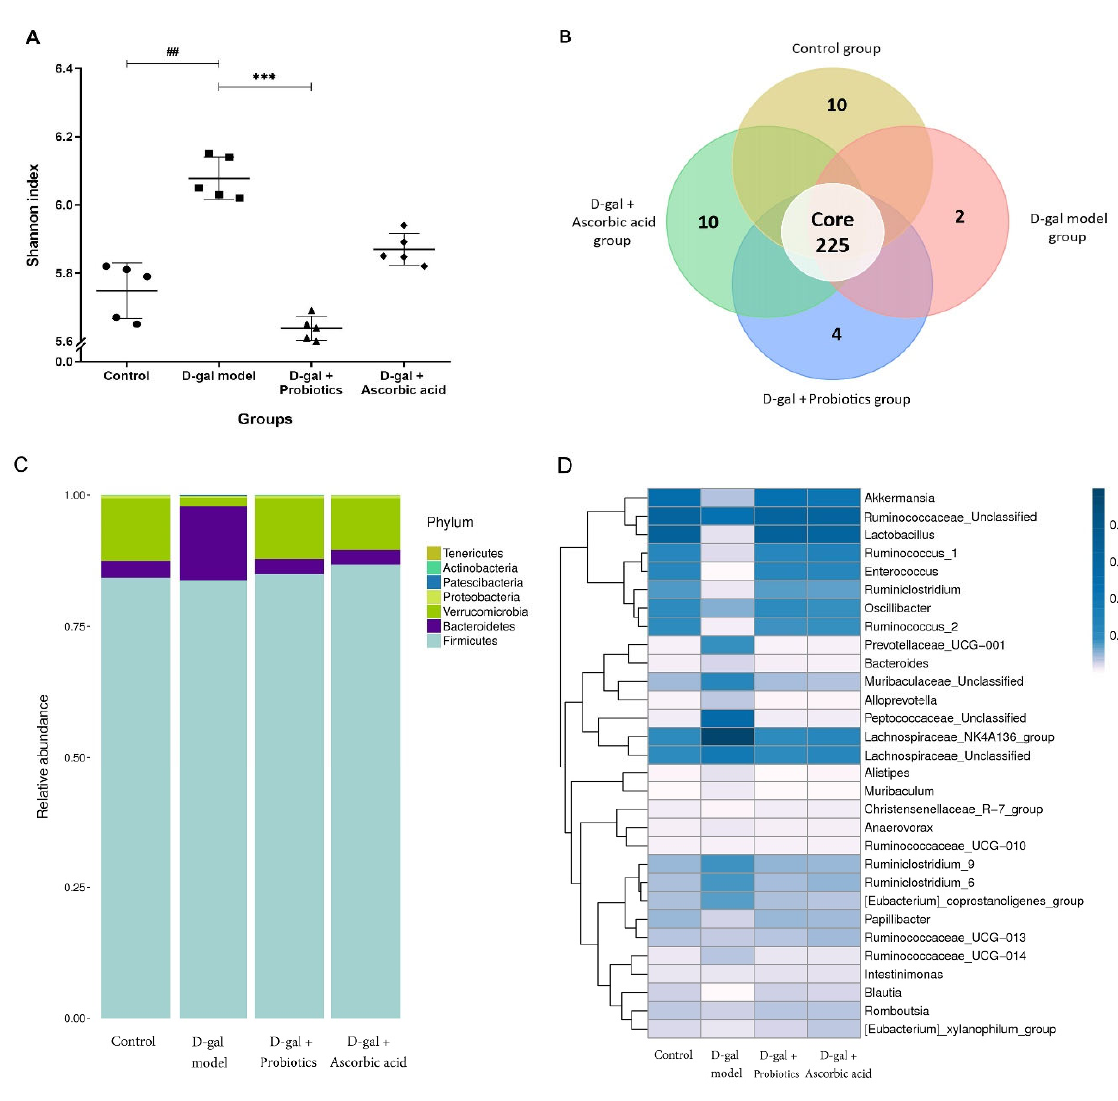
Figure 5. Effect of B. animalis MSMC83 treatment on composition of gut microbiota. Shannon index ( A ), Venn diagram representation of the number of OTUs ( B ), relative abundance of gut microbiota at the phylum level ( C ), heatmap of the gut microbiota at the genus level ( D ), and relative abundance of gut microbiota at the family level ( E ). All data are indicated as mean ± SD of 5 mice per group. ● , ■ , ▲ , ◆ as individually in each group. # p < 0.05, ## p < 0.01 as compared with the control group. * p < 0.05, *** p < 0.001, as compared with the D ‐ gal model group. 4. Discussion Oxidative stress induced by D ‐ galactose has three different pathways. In the first pathway, high levels of D ‐ gal lead to an increase in galactitol through a reaction catalyzed by galactose reductase. The accumulation of galactitol in cells affects osmotic pressure and causes abnormalities of the antioxidant defense system. Additionally, D ‐ galactose can stimulate ROS production through stimulation of NADPH oxidase. D ‐ galactose is oxi ‐ dized into aldehydes and hydrogen peroxide, which can generate ROS. This pathway is an important factor in quickly accelerating the mechanisms that cause oxidative stress [25]. Previous studies have found that excessive amounts of ROS lead to oxidative stress, which has been confirmed to be a leading cause of many types of organ damage [26]. The liver produces large amounts of ROS, which lead to liver damage, and its function